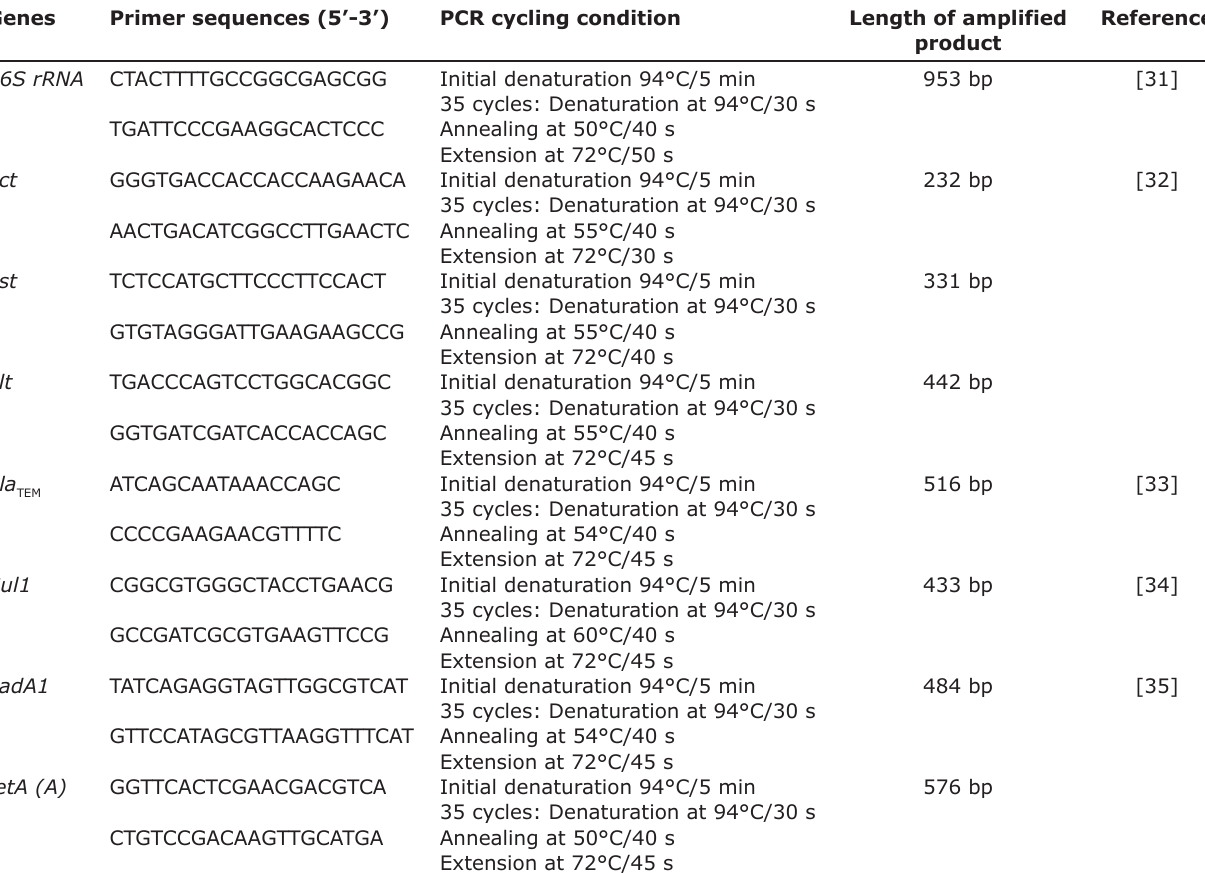
Table-1: Oligonucleotide primer sequences, cycling conditions, and length of the amplified product from Aeromonas spp. isolates. Genes Primer sequences